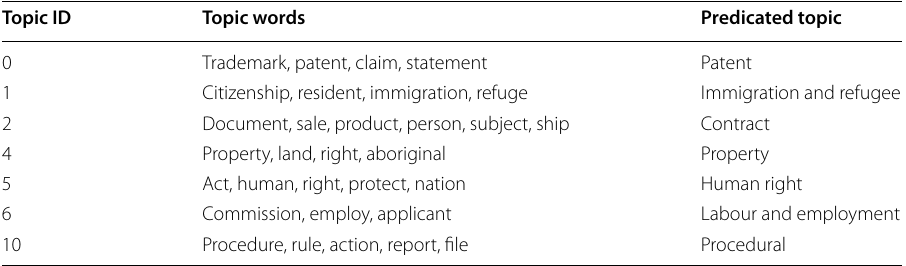
and | T | = 10 + w S j j